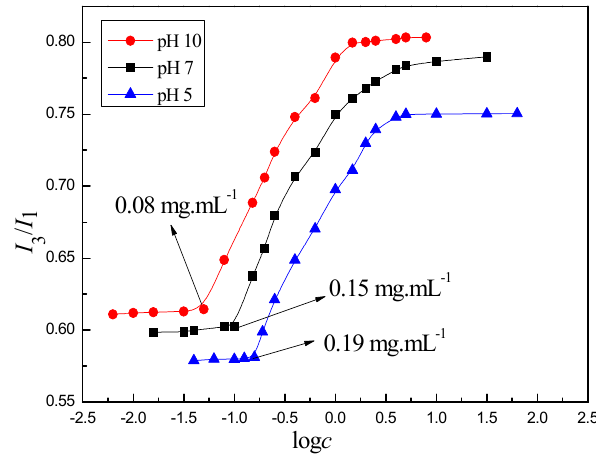
Figure 4. Curves of the I 3 / I 1 ratio of pyrene (Py) at 25 °C for various concentrations of P2 aqueous solution at pH 5, 7, and 10.